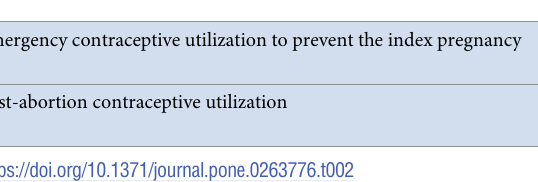
Table 2. Use of emergency contraceptives to prevent the index pregnancy among 397 women seeking termination of pregnancy, Northwest Ethiopia, 2019.